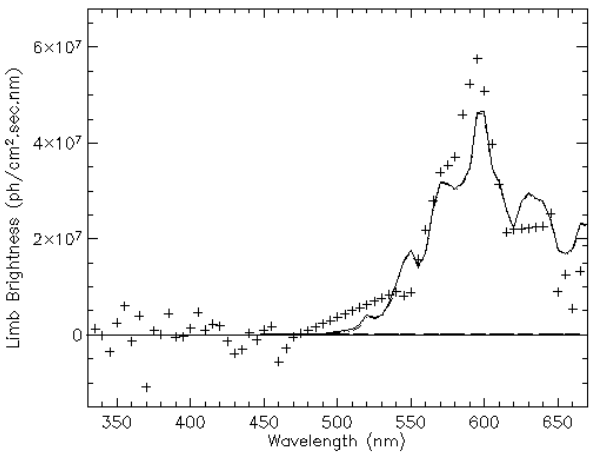
Fig. 8. Least-squares fitting of the chemiluminescent FeO ∗ model Fig. 7. Least-squares fitting of the chemiluminescent FeO ∗ model spectrum (dot-dot-dash), the NiO ∗ model spectrum (short dash), spectrum (dot-dot-dash), the NiO ∗ model spectrum (short dash), and the chemiluminescent NO ∗ emission (long dash), and the total and the chemiluminescent NO ∗ emission (long dash), and the total 2 2 model spectrum (solid) versus the OSIRIS observed airglow 85km model spectrum (solid) versus the OSIRIS observed airglow 85km to 90km averaged “continuum” for June and July of 2008 (+ + +), to 90km averaged limb “continuum” for June and July of 2004 all averaged over 5nm intervals. The ratio of NiO ∗ to FeO ∗ is (+ + +), all averaged over 5nm intervals. The ratio of NiO ∗ to 0.05 ± 0.05 and NO ∗ to FeO ∗ is 0.0 ± 0.1, integrated over the full FeO ∗ is 0.1 ± 0.1 and NO ∗ to FeO ∗ is 0.2 ± 0.1, integrated over the 2 2 spectral range of Fig. 8. At the lowest tangent altitudes, near 80km, full spectral range of Fig. 7. there appears to be an additional unexplained emission source in the 380 to 420nm region which impacts the NO ∗ component fit in each 2 of years 2003, 2004 and